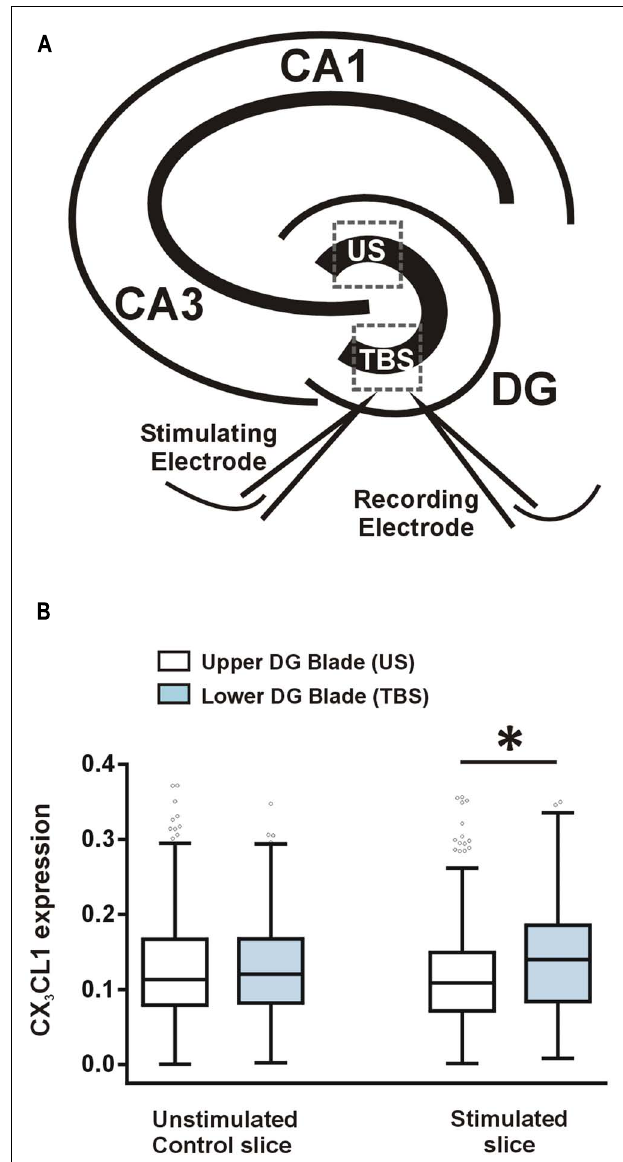
FIGURE 3 | CX 3 CL1 expression increases 2 h following theta-burst stimulation-induced LTP in the DG of acute hippocampal slices. (A) Schematic diagram illustrating the position of stimulating and recording electrodes in hippocampal LTP experiments. Electrodes were always placed in the medial molecular layer of the lower blade of the DG approximately 100–200 μ m apart. US, unstimulated DG blade;TBS, theta-burst stimulated blade. (B) Box plots showing the distribution of CX 3 CL1 fluorescence intensities in the upper and lower blades of the DG in stimulated slices and time-matched control slices. Asterisk indicates significant difference from the US blade (Kruskal–Wallis ANOVA and Dunn’s multiple comparisons post hoc tests; p < 0.001).